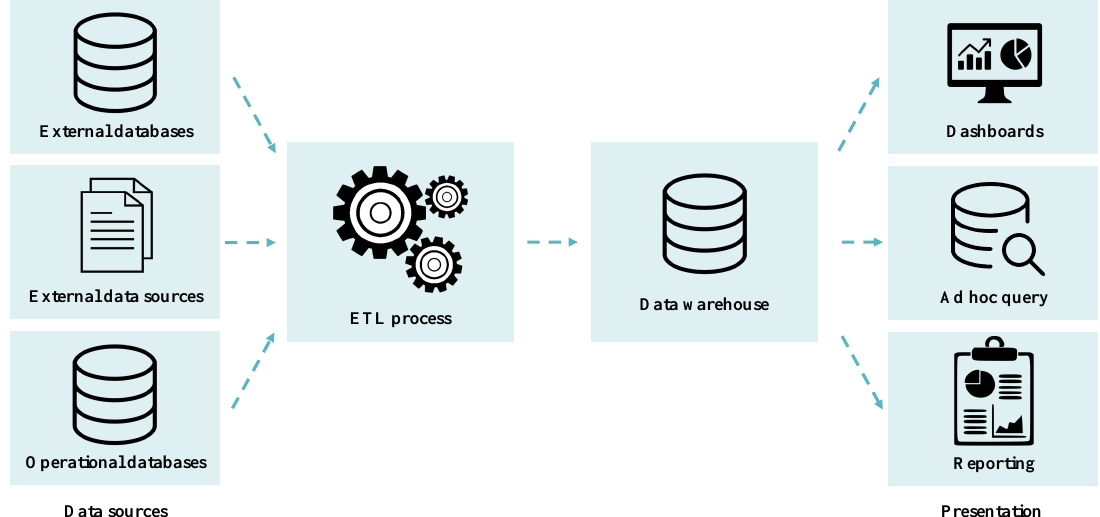
Figure 1. General architecture of the business intelligence process (adapted from